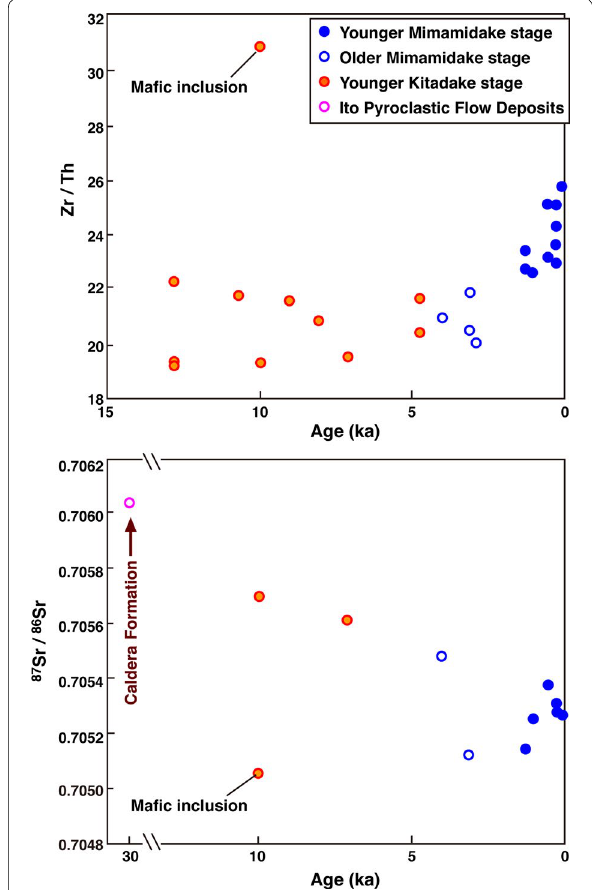
Fig. 4 Temporal variations of Zr/Th and 87 Sr/ 86 Sr in the products of Sakurajima Volcano. Modified from Uto et al. (2005). The mafic inclu- sion within dacite lava represents mantle-derived magma supplied into a felsic magma chamber